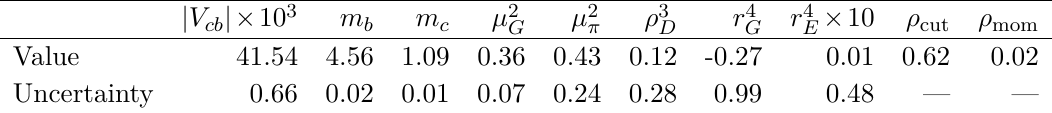
(1 GeV) , ¯ m (2 GeV) , the c b and ρ . All parameters are expressed in cut mom